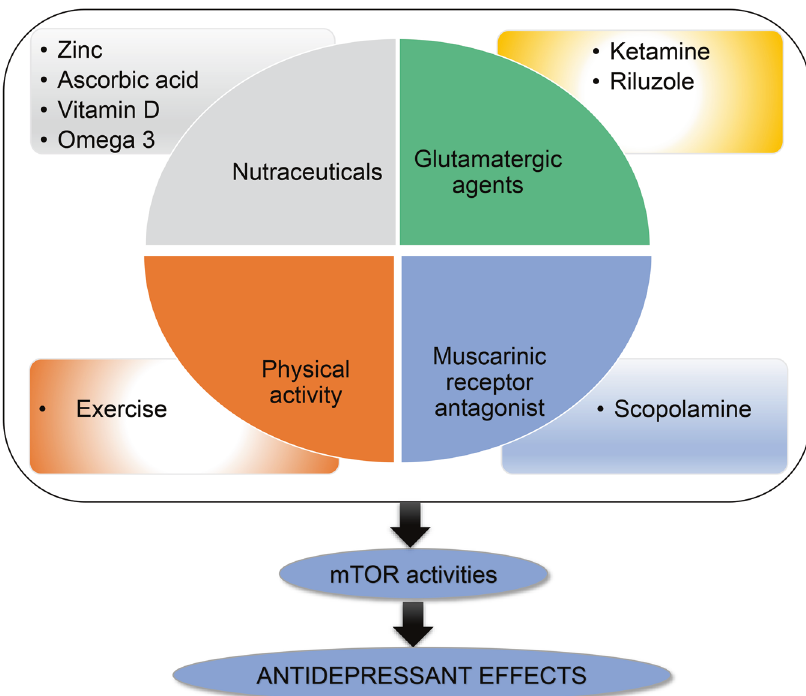
Fig. 6 Seasonal Affective Disorder: Pathogenesis, symptoms, and circadian regulation. The various hypothesis such as phase shift, melatonin, and serotonin hypothesis, have been proposed for pathogenies of SAD. These factors may convergently in fl uence the brain circadian clock, which may further in fl uence the neural mechanisms underlying SAD and other mood disorders. Like mood disorders, SAD is also characterized by poor mood, anhedonia, loss of energy, weight gain, hypersomnia